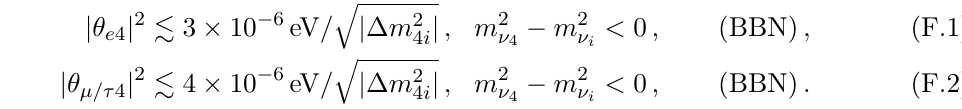
Figure 11 . Left panel: N eff as a function of | θ 4 α | for eV-scale sterile neutrinos with ∆ m 2 ≡ m 2 m 2 > 0 . Solid lines correspond to our calculation using NUDEC_BSM and dashed lines correspond to ν i found for | θ | . Right panel: 95% CL BBN exclusion contour for | θ 4 α | for sterile neutrinos 4 µ/τ